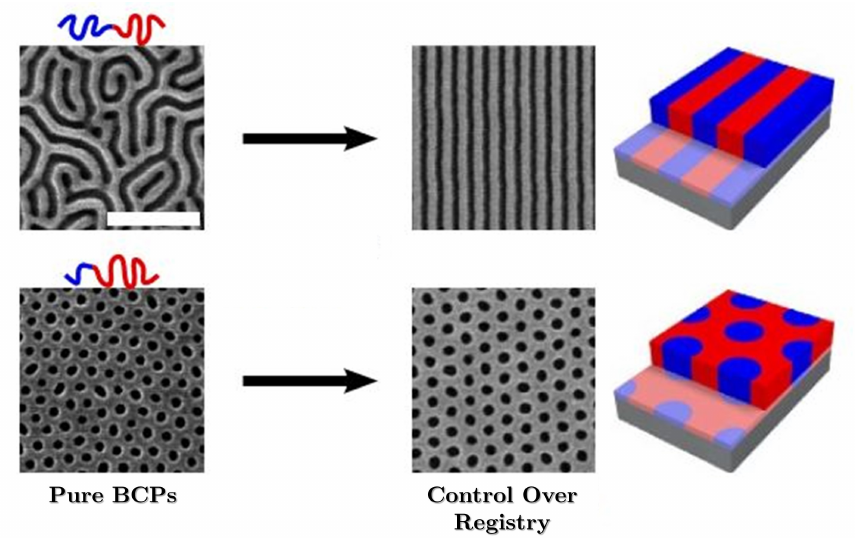
Figure 24. Schematic of self-assembly. The AM method uses a substrate template to give long-range order to lamellar and cylindrical self-assembled block copolymer films. Reprinted with permission from Ref. [177]. Copyright 2016,